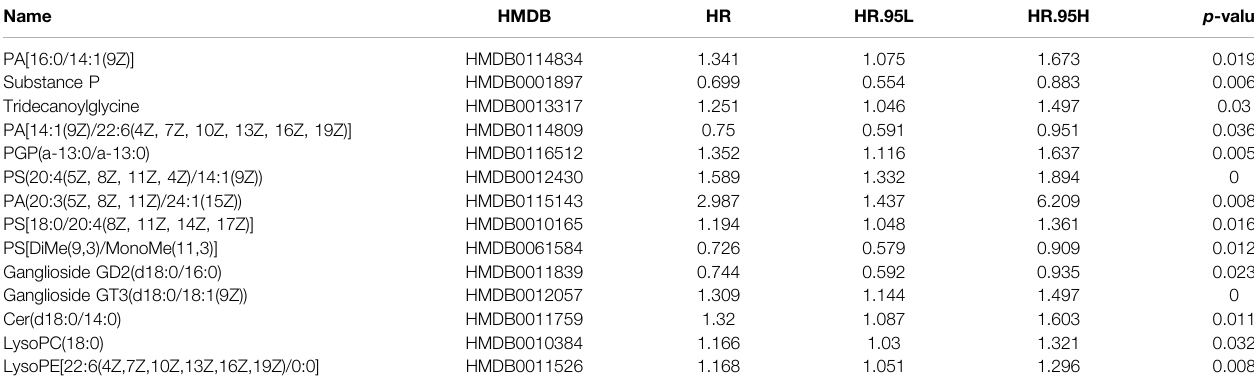
TABLE 2 | Univariate Cox regression analysis for the differential lipid metabolites.